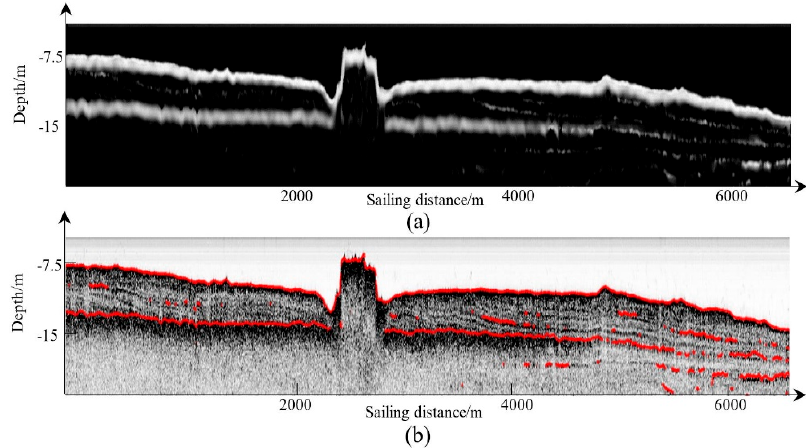
Figure 14. The filtered result and the picked result. ( a ) shows the filtered image using a large σ min . Picking horizons from ( a ), ( b ) shows the superposition of picked horizons and the original SBP image.